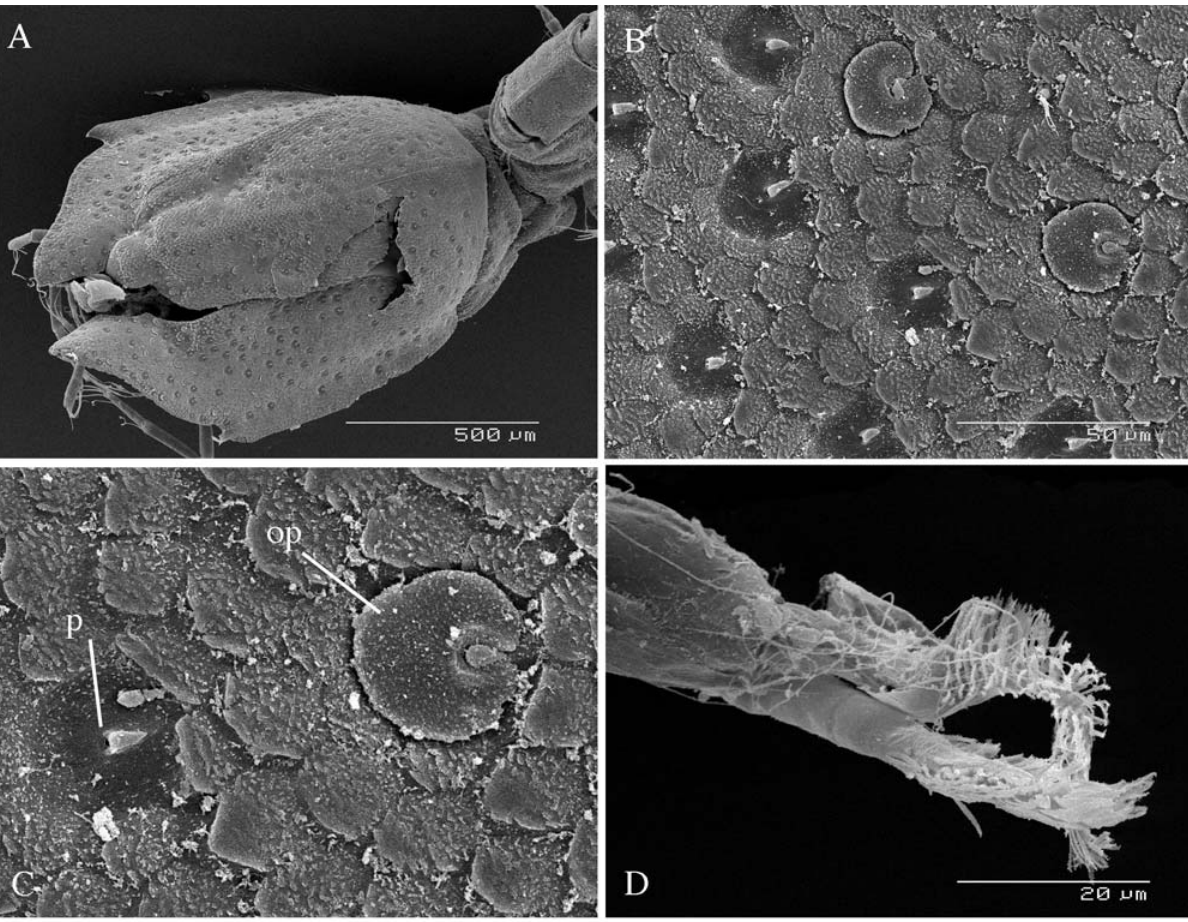
Fig. 3. – Eocuma rosae sp. nov., preadult female, SEM photographs: A, dorsal view of the carapace; B, close-up of the carapace cuticle where several sensory structures can be seen; C, detail of two sensory structures of B, one of them without the operculum (op) and showing the triangular projection where the operculum was attached and in front of it, a small pore (p); D, sensory setae at the tip of the uropod